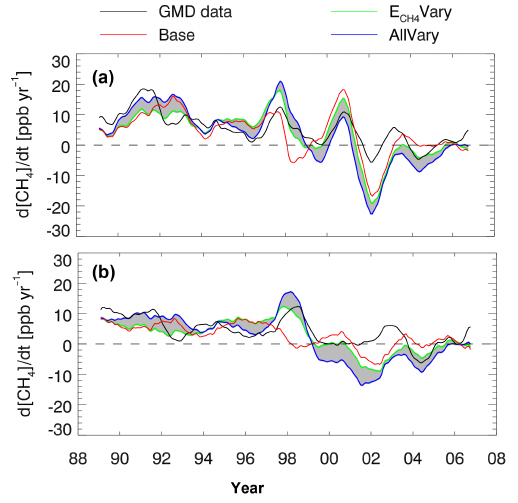
Figure 4. (a) Twelve-month running mean atmospheric growth rate of methane (ppbvyr − 1 ) for the average of 92 GMD stations and from model output for several scenarios averaged for those station locations. The shaded area is the difference between the E CH and AllVary scenarios, which indicates the total contribution of non- linear feedbacks (i.e., from variations of CO emissions and variables input to the parameterization of OH) of the CH 4 –CO–OH system to methane’s growth rate. (b) Same as (a) but for the average of 17 GMD stations, which covers 100% of the simulation period. Refer to Figs. S4 to S7 for methane’s growth rate from other